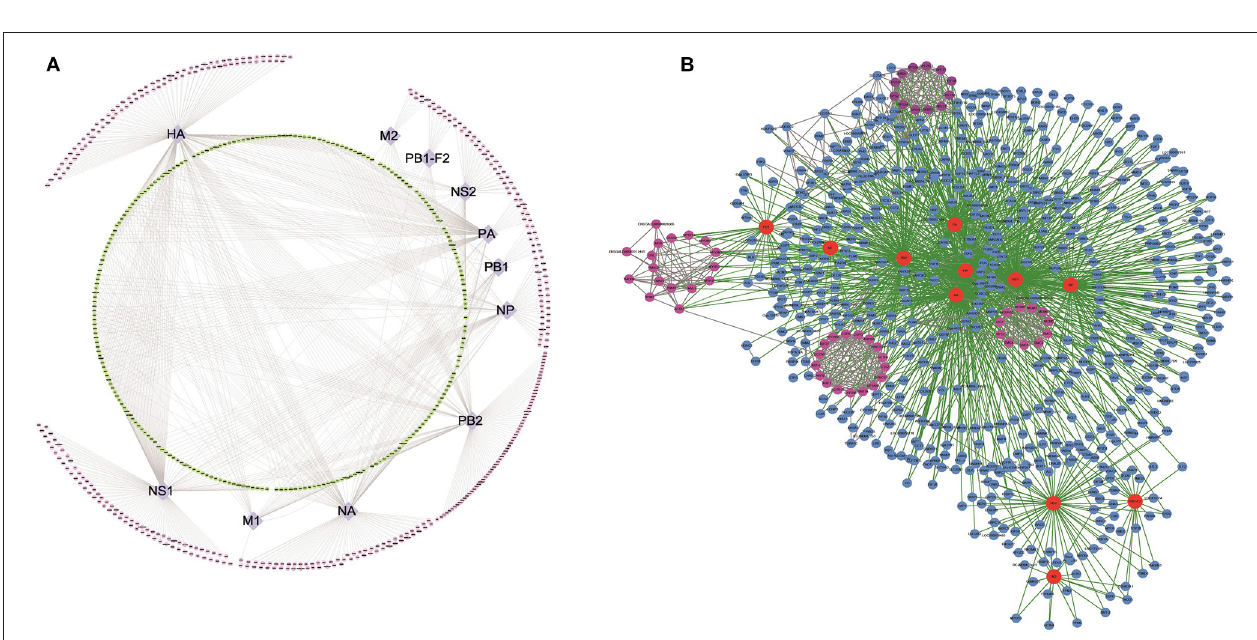
FIGURE 2 | Global landscape of the H5N1 AIV–chicken protein complexes. In total, 1,043 H5N1 AIV–chicken interactions are represented, linking 11 H5N1 AIV proteins and 621 chicken factors. (A) Types of host interacting proteins. Chicken proteins that interact with H5N1 AIV proteins (purple nodes in the middle ring) are denoted with two colors: the pink nodes in the outer ring represent the host proteins that interact with only one specific virus protein, while the green nodes in the inner ring represent the host proteins that interact with a variety of viral proteins. (B) Network representation of the H5N1 AIV–human PPIs. The host–pathogen interaction map for H5N1 AIV contained 1,475 interactions between 11 influenza virus proteins (red nodes) and 621 cellular proteins (blue and pink nodes). Some of the host proteins interact with the virus in the form of protein complexes (pink nodes). C-terminal domain found in proteins belonging to the helicase proteins, including the RRM, AAA, SM00913, DEXDc, HELICc, superfamilies 1 and 2. These families encompass a large number and MCM domains ( Table 3 ). MCM is required for the initiation of DNA and RNA helicases from archaea, eubacteria, of eukaryotic DNA replication (16, 17), while HELICc is the